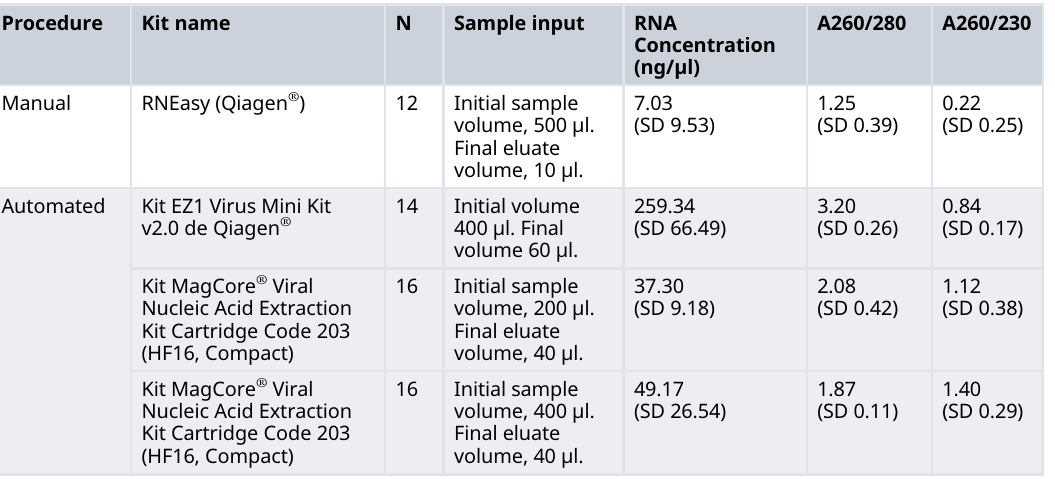
Table 1. Performance of four different ARN extraction procedures measured with NanoDrop 2000